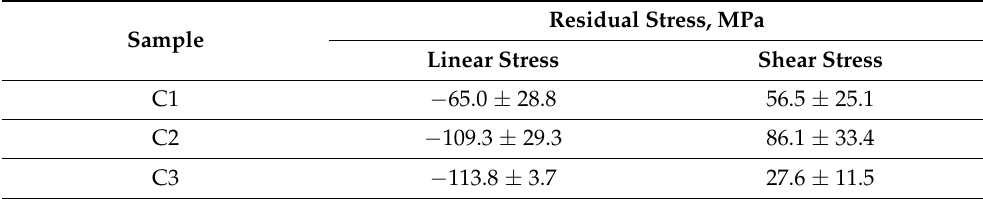
Figure 16. Residual stress diagrams were obtained for examined cermet coatings. Table 3. Mean residual stress values in various cermet coatings sprayed onto AZ31 magnesium sub-